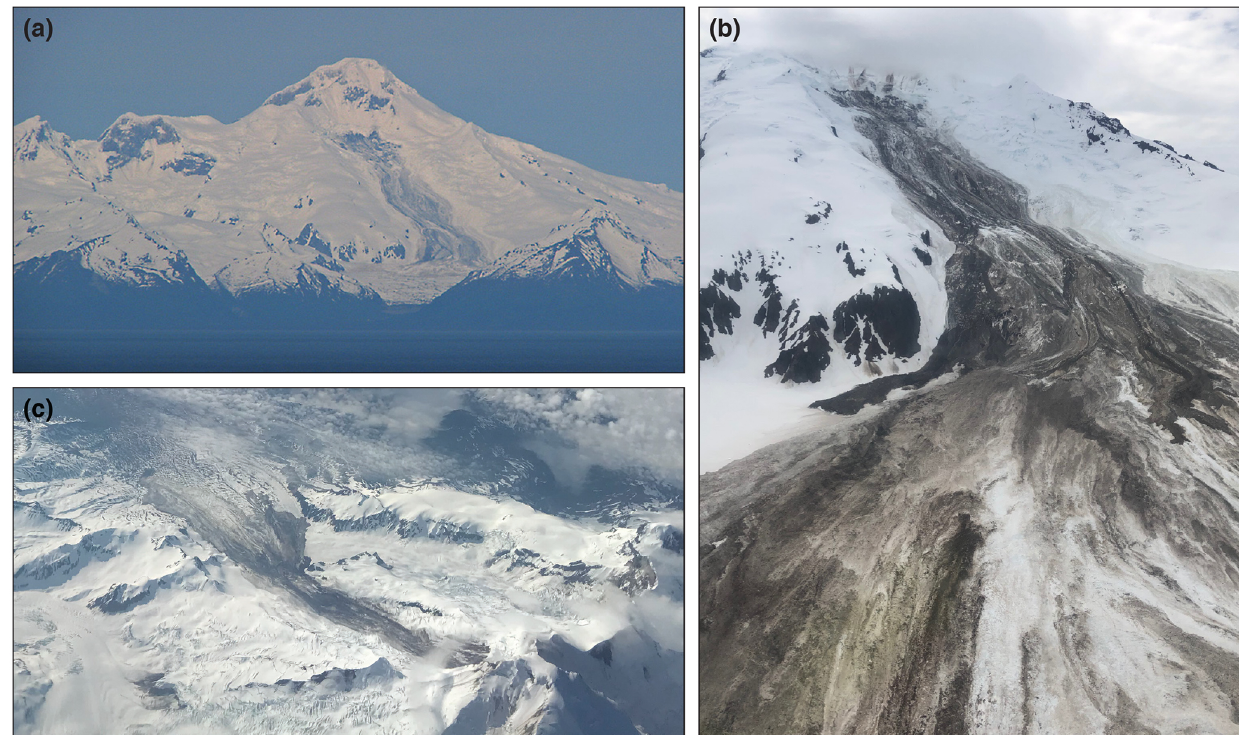
Figure 3. Photographs of the 2016 and 2019 Red Glacier avalanche deposits. (a) West-northwest-looking photograph of the 2016 de- posit taken from near Homer on 23 May 2016. Photo courtesy of Dennis Anderson, Night Trax Photography; Alaska Volcano Ob- servatory (AVO) image database ID https://avo.alaska.edu/images/image.php?id=95521 (last access: March 2021). (b) West-northwest- looking aerial photograph of the 2019 deposit, taken 22 June 2019. Photo courtesy of Loren Prosser; AVO image database ID https: //avo.alaska.edu/images/image.php?id=140871 (last access: March 2021). (c) Southeast-looking aerial photograph of the 2019 deposit, taken 25 June 2019. Photo courtesy of Greg Johnson; AVO image database ID https://avo.alaska.edu/images/image.php?id=141431 (last access: March 2021).